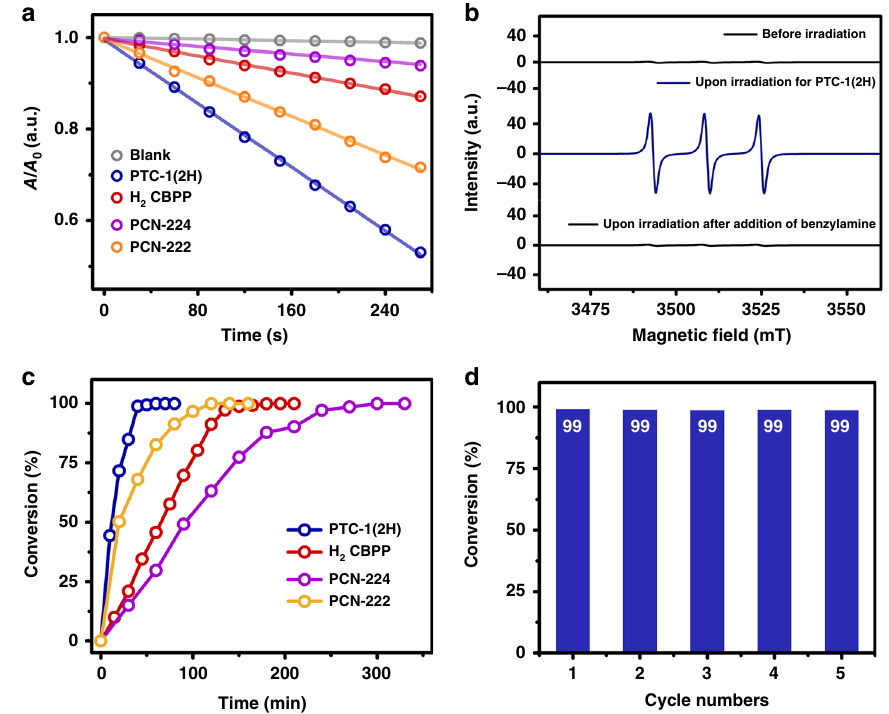
Fig. 5 Heterogeneous photocatalytic behavior of PTC-1(2H). a Comparison of absorbance decay rate at 410 nm of DPBF in the presence of different photocatalysts in CH 3 CN upon visible light irradiation of λ > 510 nm; b ESR detection of 1 O 2 generation over PTC-1(2H) trapped by TEMP in CH 3 CN; c comparison of time-dependent heterogeneous catalytic ef fi ciency of different photocatalysts; d recycle test of PTC-1(2H) in the photo-induced oxidative coupling of benzylamine to N -benzylidenebenzylamine. Source data are provided as a Source Data fi le.